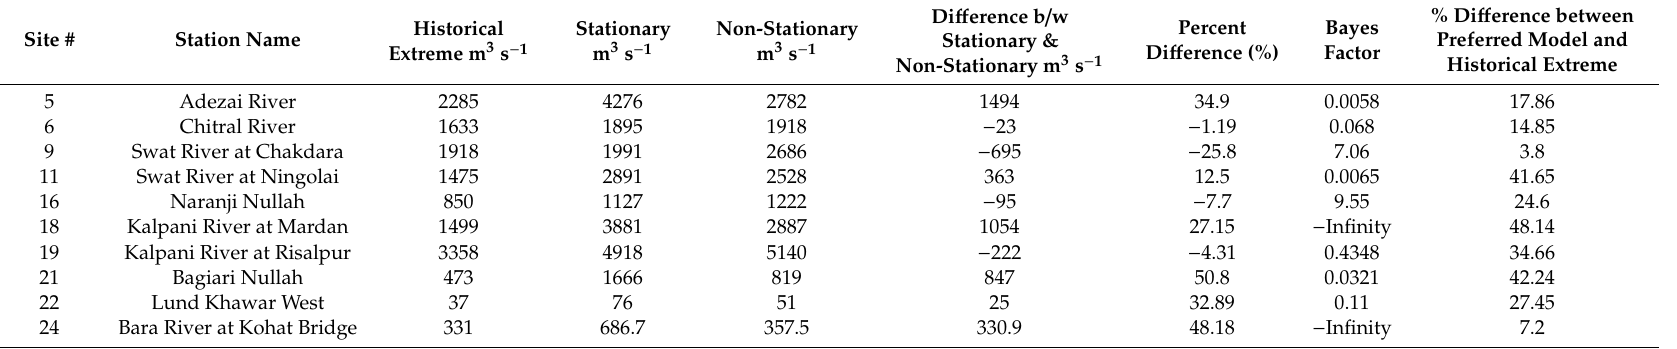
Table 6. Comparison between 100-year flood estimates using the stationary and non-stationary Bayesian models for “at site modeling” for the KRB,